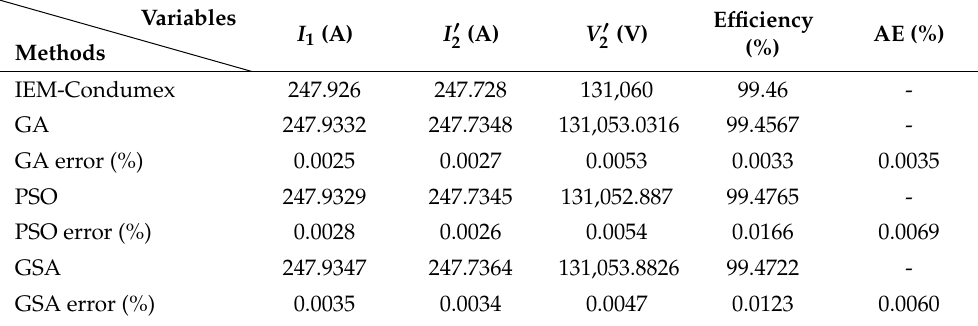
Table 9. Electrical variables at full load of a single-phase transformer 33 MVA, 230,000/ at 60